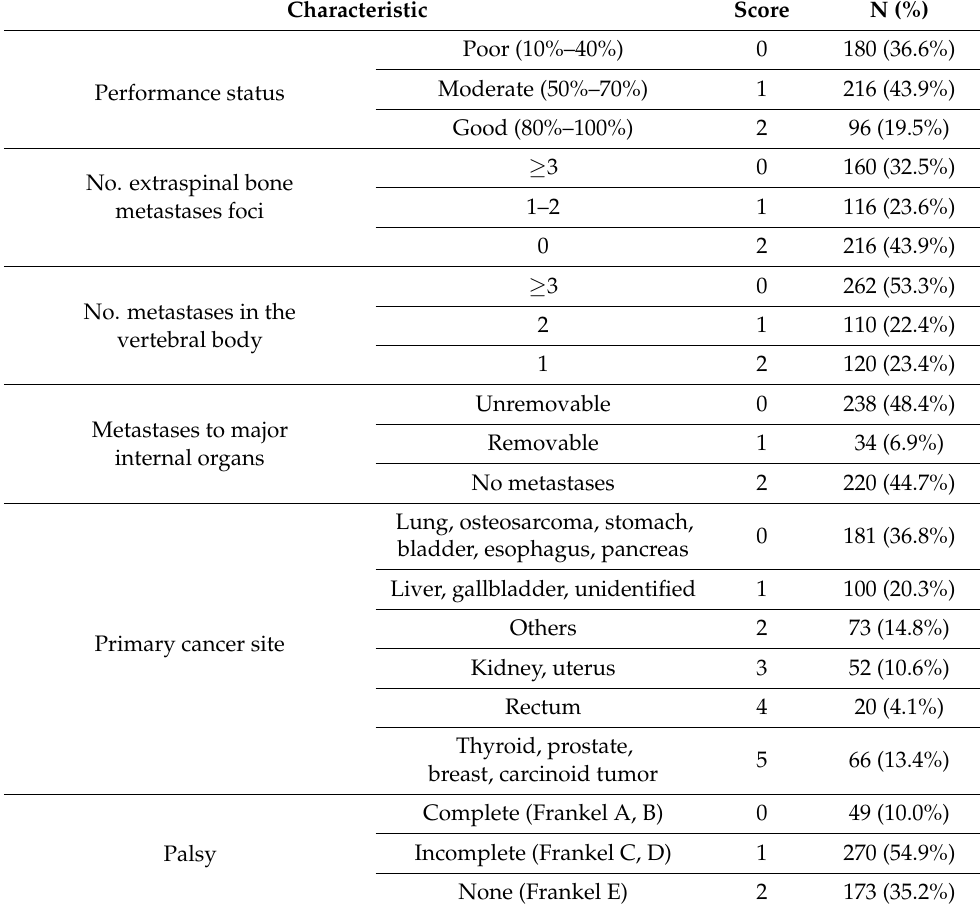
Table 2. Number of patients according to each item of revised Tokuhashi scoring